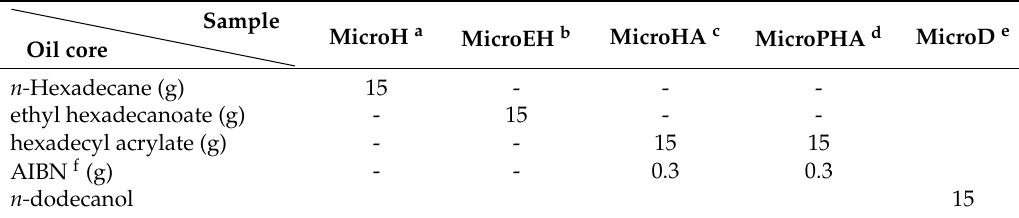
Table 1. Component content of oil phase